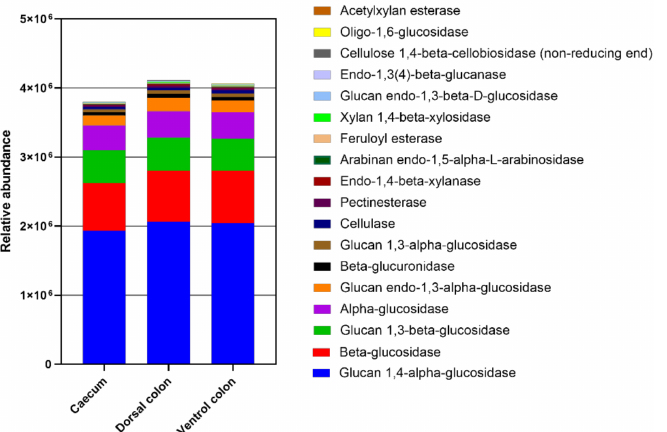
Figure 8. The abundance of enzymes related to plant cell wall degradation predicted by phylogenetic investigation of communities by reconstruction of unobserved states (PICRUSt). PICRUSt is a bioinformatics software package designed to predict metagenome functional content from marker gene (e.g., ITS)